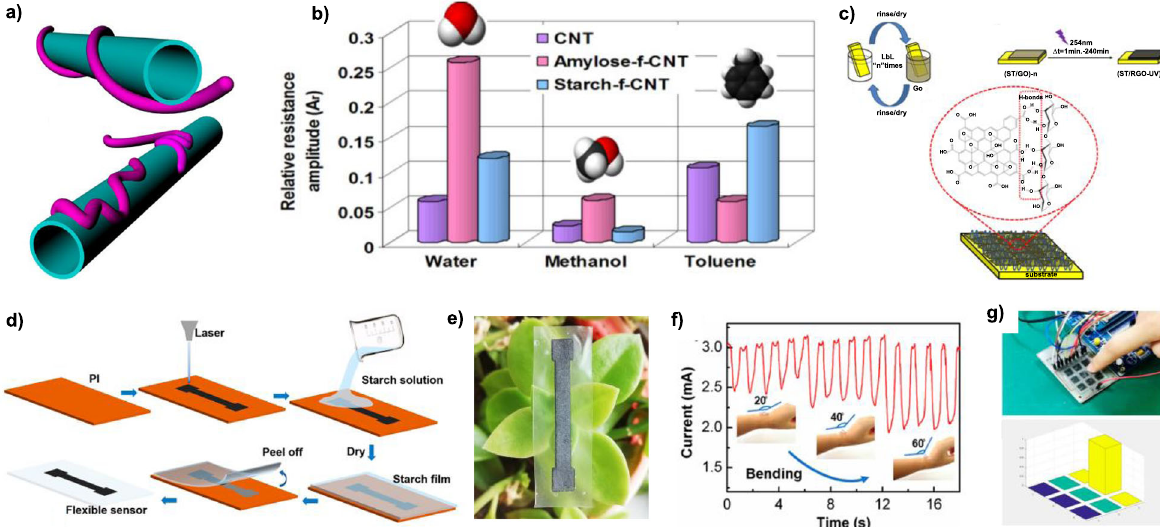
Fig. 4 Flexible gas and multifunctional sensors based on starch fi lms. a Possible conformation of amylose-f-CNT and starch-f-CNT sensors and b their selectivity for different vapors. Reproduced with permission 97 . Copyright 2012, Elsevier. c Illustration of the layer-by-layer (LbL) deposition, photochemical reduction, and hydrogen bonding of the starch-GO sensor on quartz substrate. Reproduced with permission 98 . Copyright 2020, American Chemical Society. d The preparation procedure and e photograph of a multimodal fl exible sensor on starch fi lm. f Real-time current signal for monitoring of wrist bending with different angles. g The sensor matrix for detection of spatial pressure. Reproduced with permission 37 . Copyright 2020, American Chemical Society.